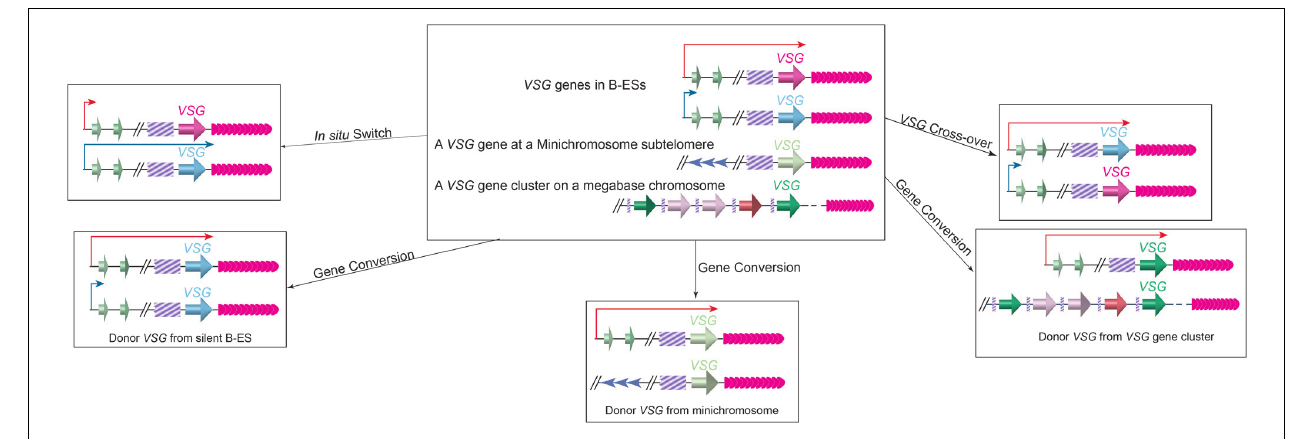
VSG gene is lost.The VSG donor can come from a silent B-ES (bottom left), a minichromosome subtelomere (bottom middle), or a VSG gene array (bottom-right). In VSG cross-over (top right), the active VSG and a silent VSG (most often from a silent B-ES) exchange their loci reciprocally, resulting in a new VSG gene in the active B-ES without losing any genetic information.The cross-over site is often found within the 70 bp repeats upstream of the VSG genes, although it can locate more upstream, and all B-ESs have high sequence